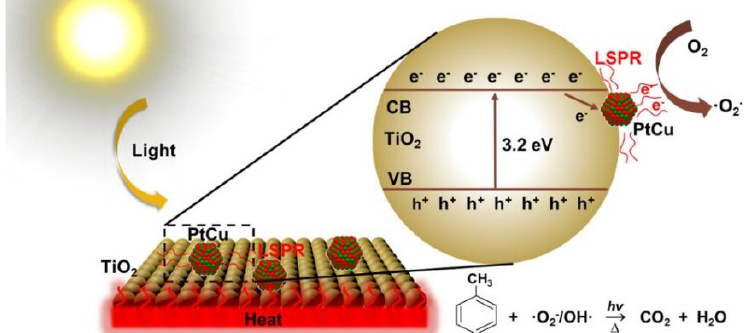
Figure 14. Mechanistic diagram of the photo − thermal catalytic degradation of the toluene reaction on Pt − Cu/TiO 2 catalysts (Reprinted/adapted with permission from Ref. [120]. Copyright 2022, copyright American Chemical Society).